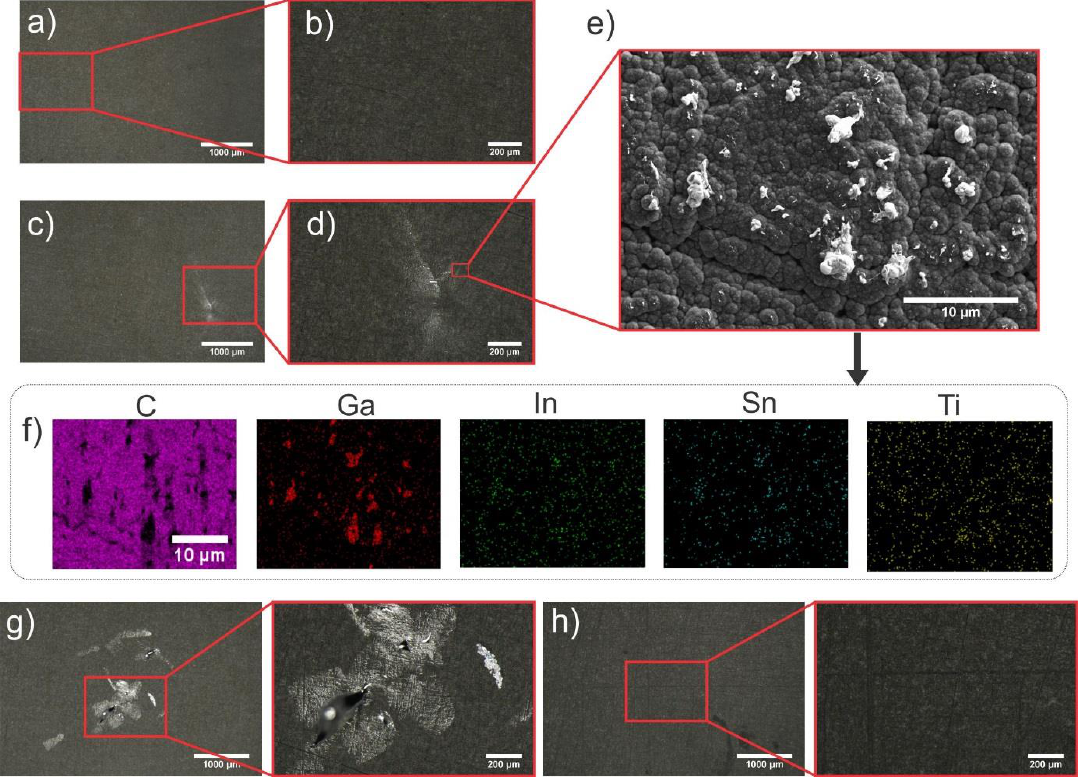
Figure 3. ( a – d ) Optical microscopy images of an oxidized rough diamond surface (coated on Ti, water contact angle ≤ 5°) after the LM droplet impact test. ( a ) Substrate surface after droplet impact from a height of 10 cm, and its magnification ( b ). ( c ) Substrate surface after droplet impact from a height of 24 cm and its magnification (d). ( e ) SEM micrograph of the rough diamond substrate after the droplet impact test (24 cm height, see ( c and d )). ( f ) EDS maps (C, Ga, In, Sn, and Ti) of the sample, corresponding to ( c ) and ( e ). ( g , h ) Difference of the adhesion of LM on hydrophilic ( g ) and hydrophobic substrate ( h ) upon repeated LM deposition. Adhesion visible after 50 LM droplets deposited on hydrophilic substrate ( g ), while no adhesion is visible for the hydrophobic substrate after the same number of repetitions.